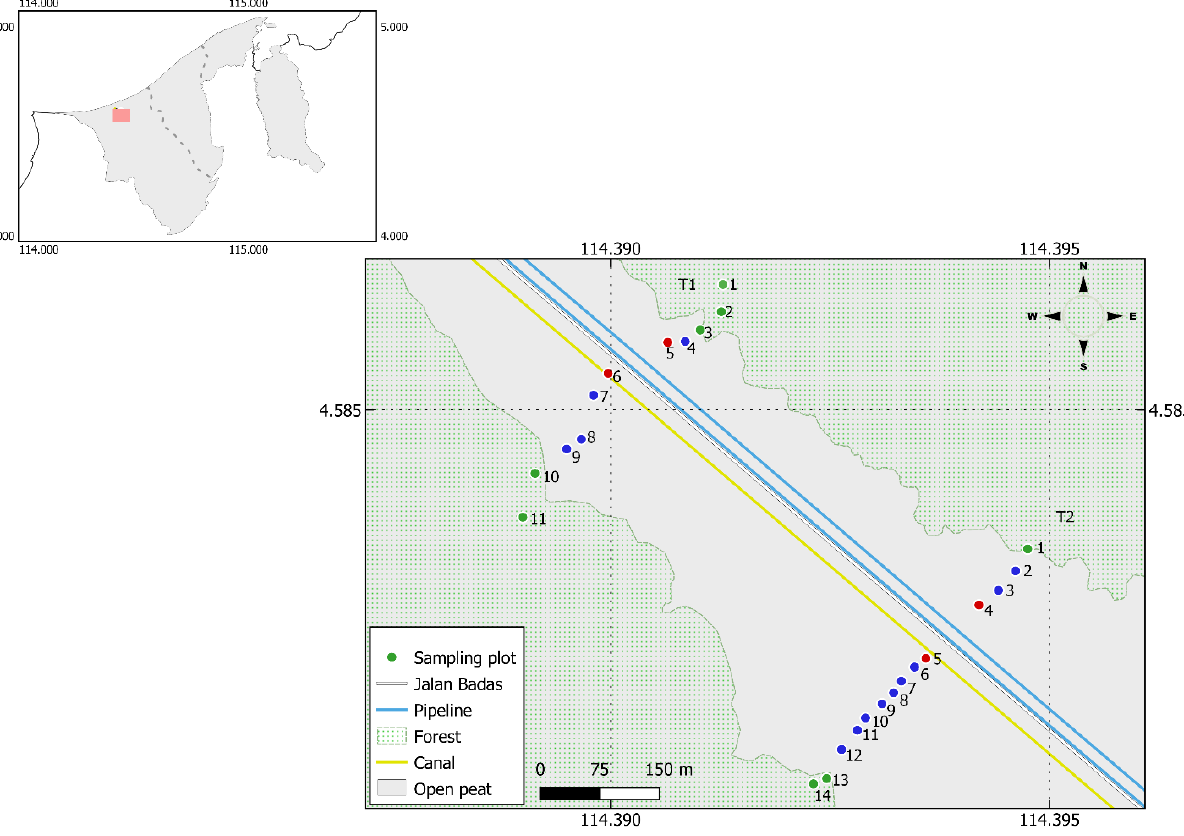
Figure 1. Map showing the location of the study sites in Badas (left). Sampling plots are colour coded along two transects (Transect 1 and Transect 2). Forest peat samples are denoted by green dots, peat samples nearest to the road are represented by red dots and the rest of the plots are marked with blue